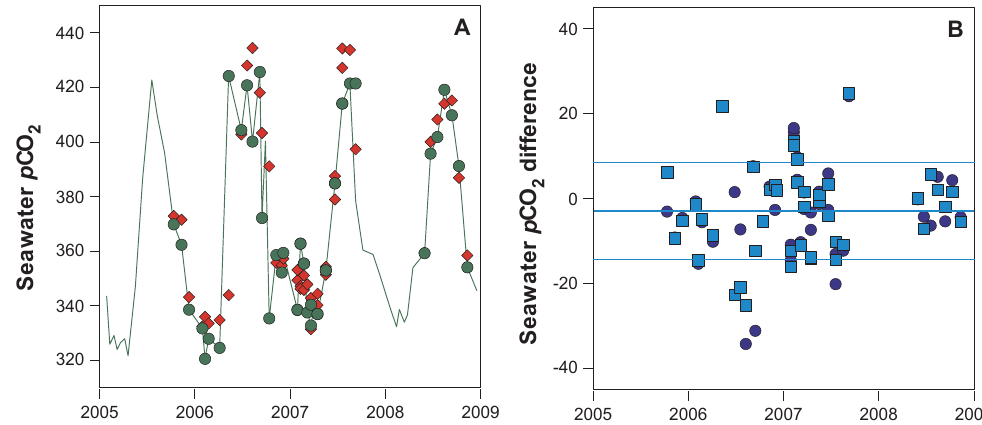
Fig. 3. Fig. 3. Comparison of computed seawater p CO 2 (µatm) with p CO 2 directly measured from the R/V Atlantic Explorer or Bermuda Testbed